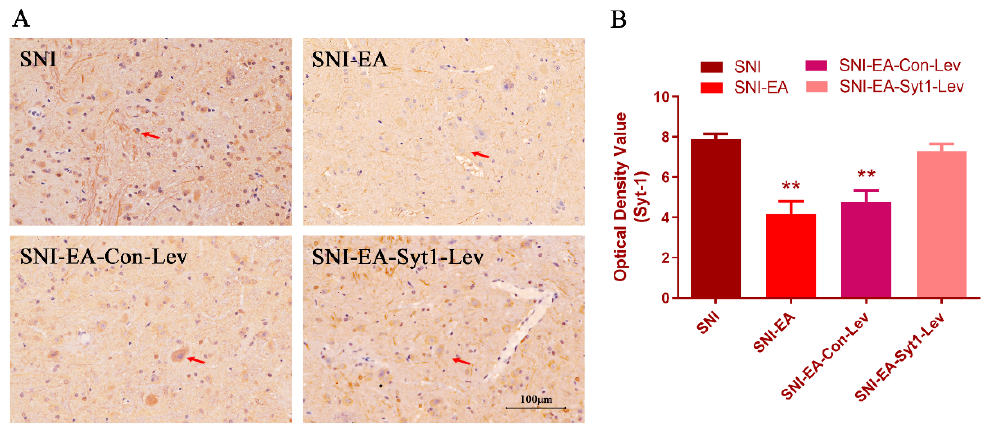
Figure 7. E ff ect of EA on Syt-1 immunoreactive cells in the laminae I-II of the SCDH (Mean ± SD, Figure 7. Effect of EA on Syt ‐ 1 immunoreactive cells in the laminae I ‐ II of the SCDH (Mean ± SD, n = n = 3). ( A ) Decreased Syt-1-IR, which EA induced were apparently reversed by Syt-1 overexpression. 3). ( A ) Decreased Syt ‐ 1 ‐ IR, which EA induced were apparently reversed by Syt ‐ 1 overexpression. Red Red arrows show Syt-1 positive cells. Scale bars, 100 µ m. ( B ) The optical density values of arrows show Syt ‐ 1 positive cells. Scale bars, 100 μ m. ( B ) The optical density values of the Syt ‐ 1 ‐ IR the Syt-1-IR cells in the laminae I-II. The values in SNI and SNI-EA-Syt1-Lev were higher than cells in the laminae I ‐ II. The values in SNI and SNI ‐ EA ‐ Syt1 ‐ Lev were higher than those in SNI ‐ EA those in SNI-EA and SNI-EA-Con-Lev. ** p < 0.01, vs. the SNI group; one-way ANOVA followed by and SNI ‐ EA ‐ Con ‐ Lev. ** p < 0.01, vs. the SNI group; one ‐ way ANOVA followed by Bonferroni test.